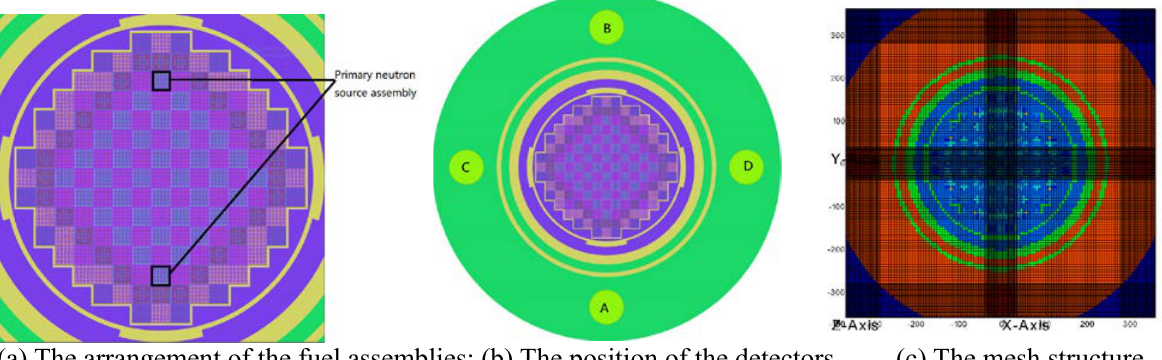
Figure 3. The structure of core layout and the detector.